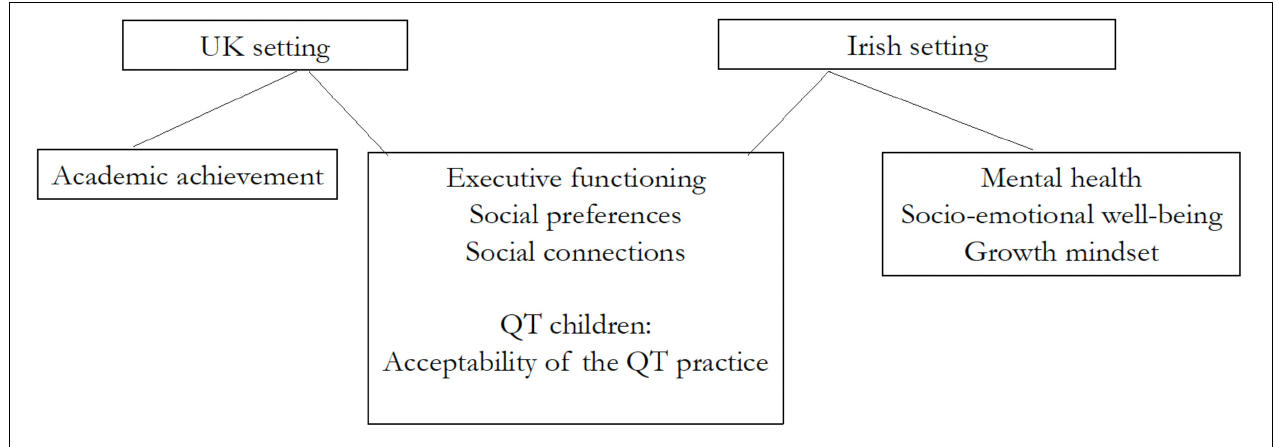
FIGURE 2 | Data collection